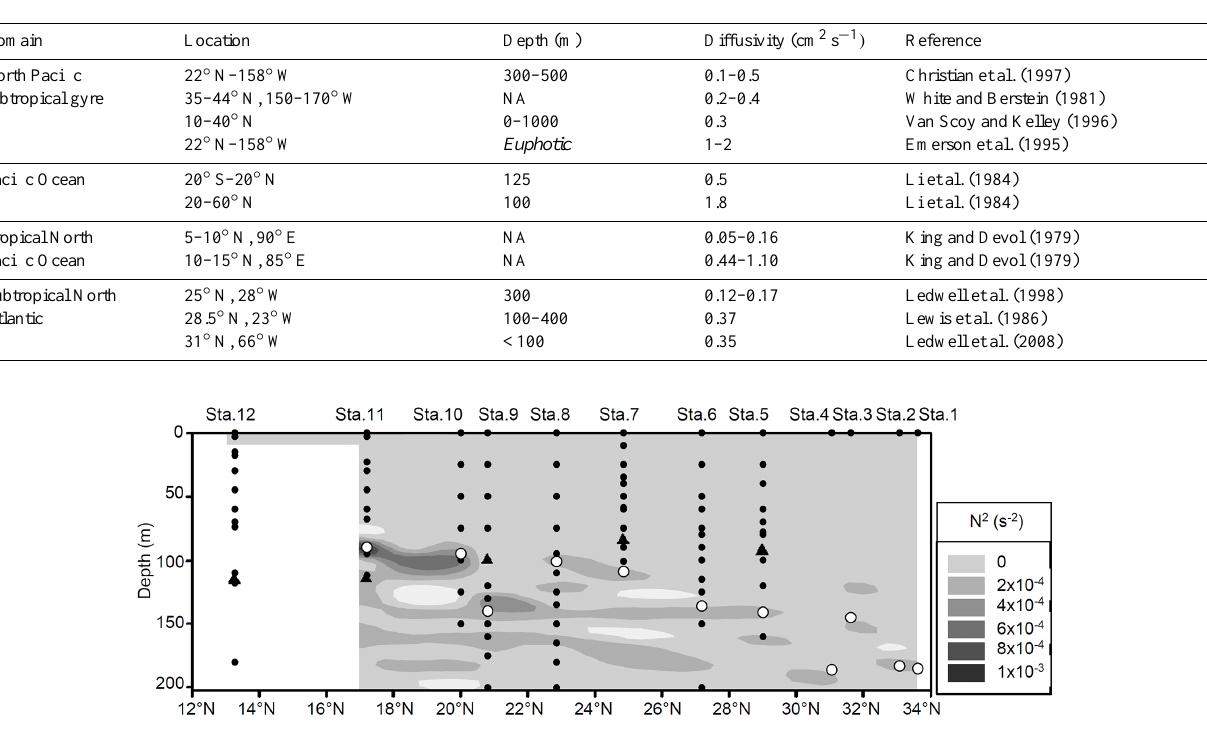
Figure 2. Vertical profiles of the Brunt-Väisäla buoyancy frequency (N 2 ) calculated from the temperature–salinity measurements. The white circles display the thermocline depth and the black triangles display the depths of 1% of photosynthetically active radiation (limit of the euphotic